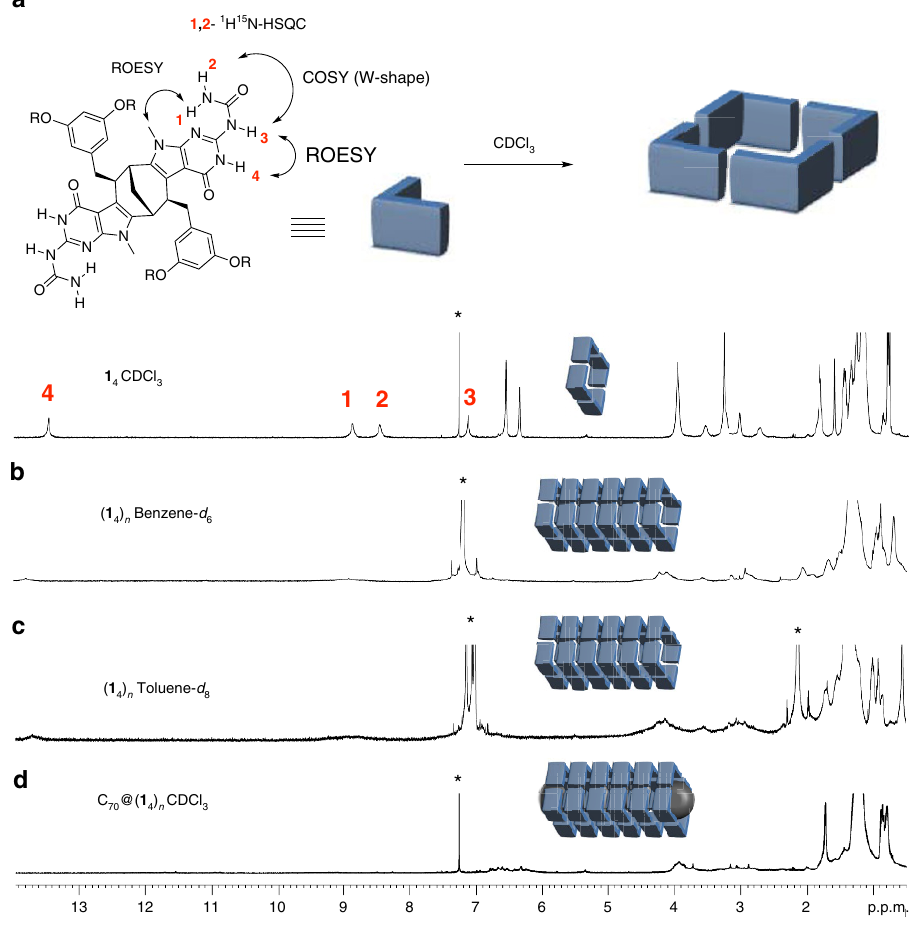
Figure 2 | 1 H NMR spectra of monomer 1 in different solvents. ( a ) 1 H NMR characterization of monomer 1 in CDCl 3 . ( b ) 1 H NMR spectrum of 1 in benzene- d 6 . ( c ) 1 H NMR spectrum of 1 in toluene- d 8 . ( d ) 1 H NMR spectrum of 1 in CDCl 3 in the presence of C 70 . *Indicates the residual solvent